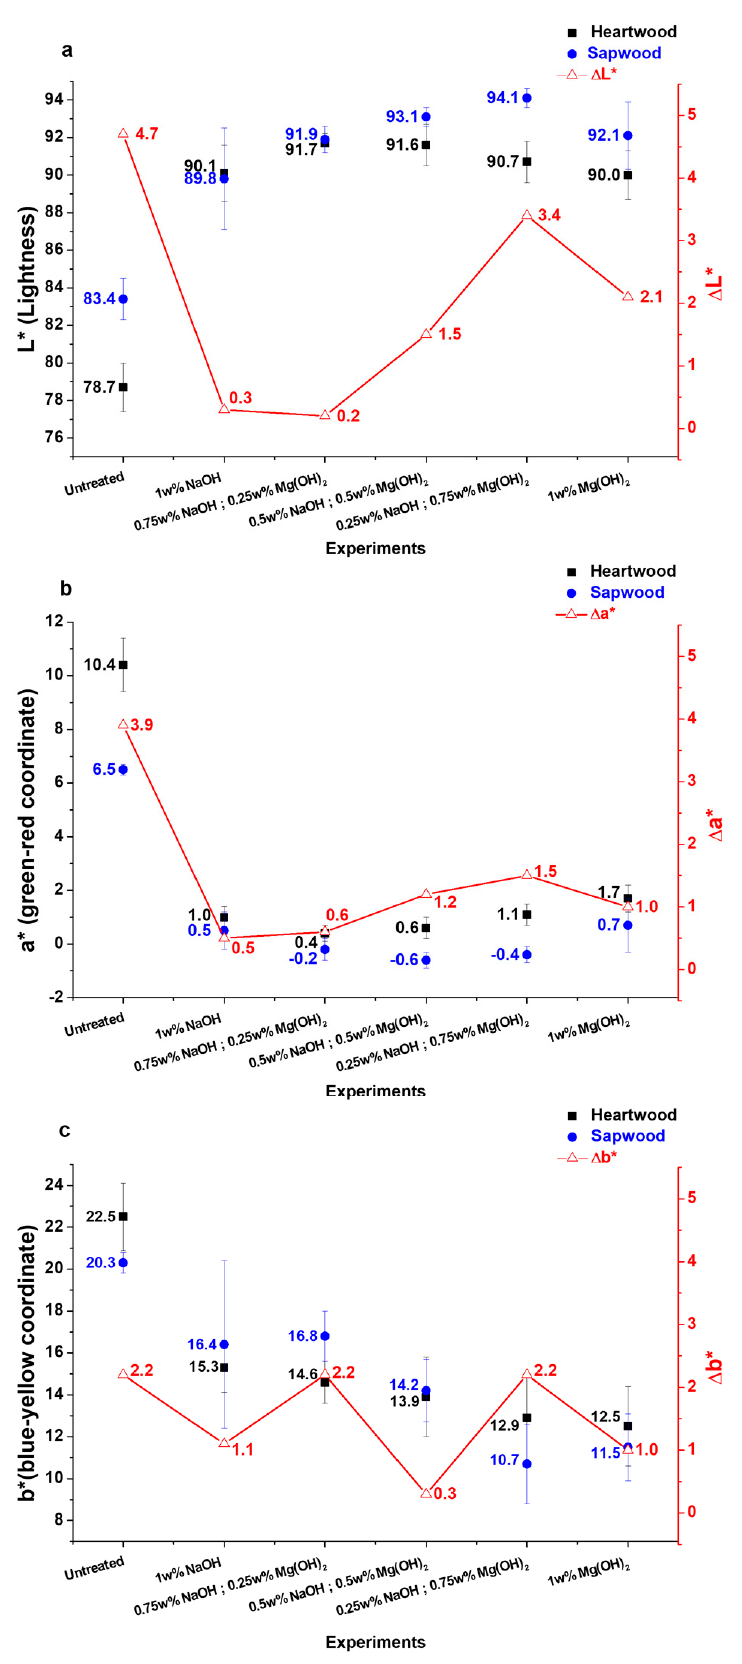
Figure 8. L* ( a ), a* ( b ), and b* ( c ) values evolution depending on NaOH/Mg(OH) 2 ratio during H 2 O 2 treatment (4% H 2 O 2 , 0.4% Na 2 SiO 3 , 60 ◦ C@1 h, mean of three